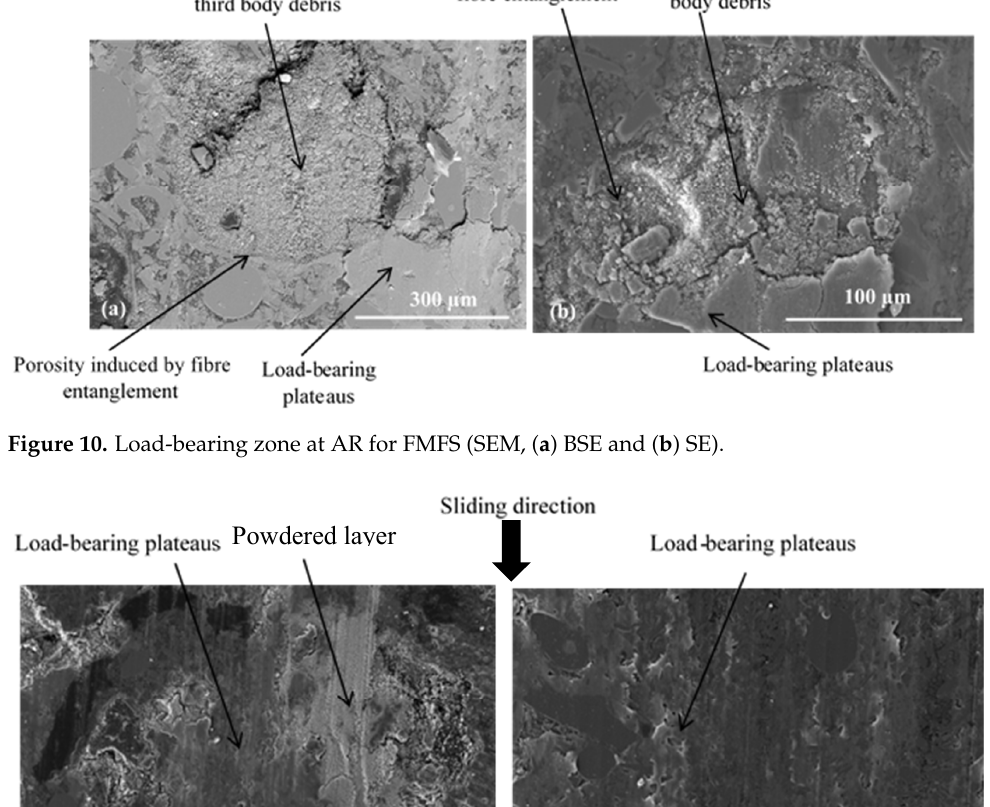
Clogged porosities Porosities